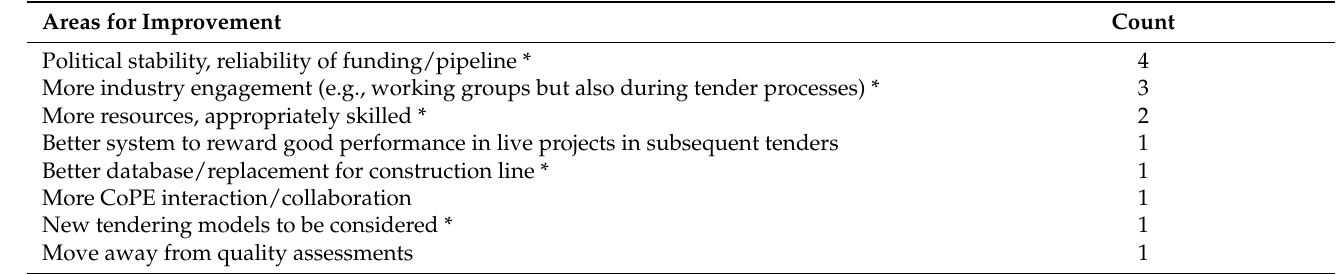
Table 13. Centres of Procurement Excellence suggested areas of improvement (note: * indicates the area was also identified by